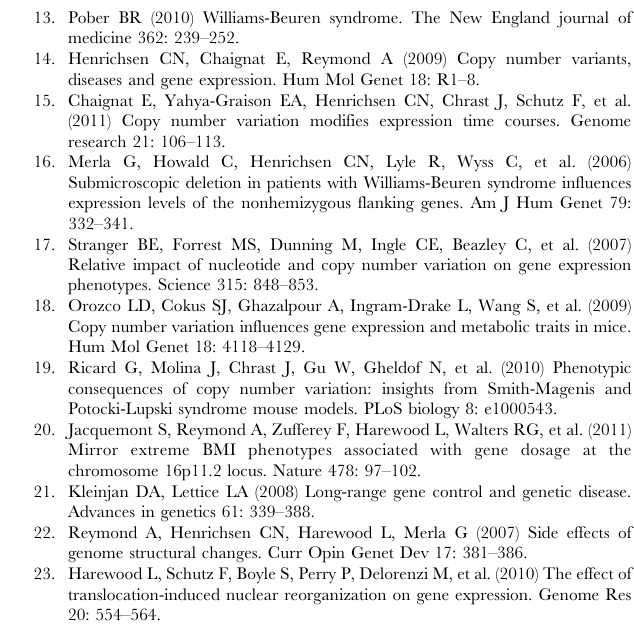
Figure S3 Heatmap showing the percent coverage of HSA7 by Bricks of each viewpoint, as well as the percent of HSA7 that overlaps between Bricks of the different viewpoints, indicating that the viewpoint interactions cluster by their linear chromosomal position. Figure S4 Close-up of the interactions of the seven viewpoints with the WBSCR in cells from a healthy control individual. The two areas highlighted in grey show the strongly interacting regions at the LCRcen (centromeric LCR) and the region within WBSCR. Pink boxes indicate the mapping of genes within the WBSCR. Figure S5 Interactions of seven genes on HSA7 in cells from a WBS patient. Windowed 4C signal of each of the seven viewpoints along the entire chromosome. The black ticks below each graph show the location of the Bricks. The density of genes is shown at the bottom. Areas highlighted in blue pinpoint some examples of strong correlation of gene-dense regions with H4K20me1 marks and highly interacting regions. The mapping of the viewpoints and the WBSCR is indicated at the bottom. Figure S6 Close-up of the interactions of the seven viewpoints with the WBSCR in cells from a WBS patient. The two areas highlighted in grey show the strongly interacting regions at the LCRcen (centromeric LCR) and the region within WBSCR. Pink boxes indicate the mapping of genes within the WBSCR.